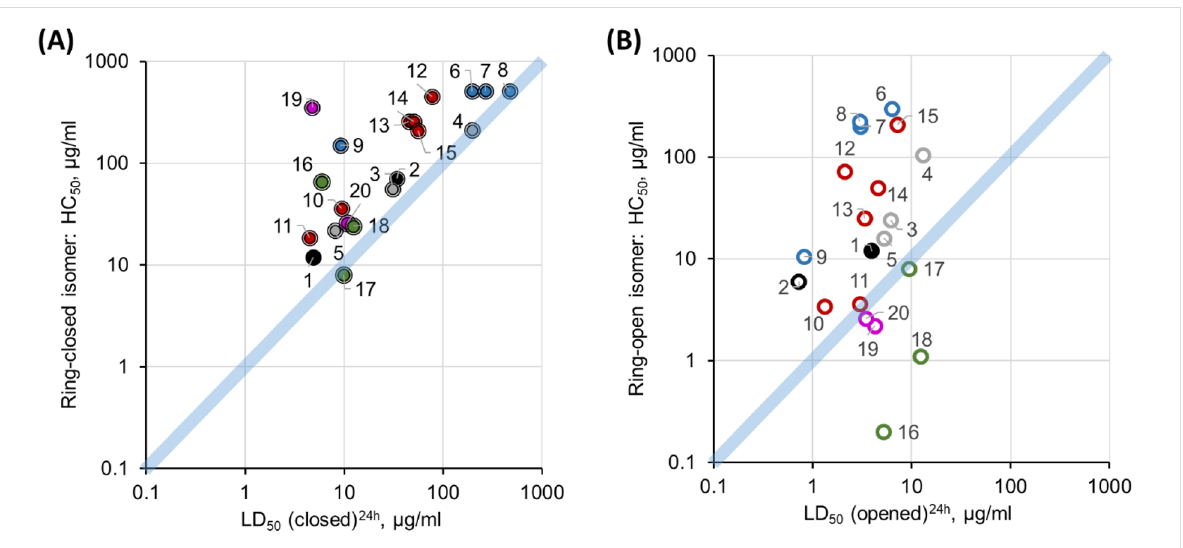
Figure 4: D. rerio embryotoxicity of GS 1 and the photoswitchable analogues 2 – 20 correlated with their in vitro hemolysis [30] for the ring-closed photoforms (A, filled circles), and for the ring-open photoforms (B, open circles). The compound numbers are shown next to the data points, and the color code is the same as in Figure